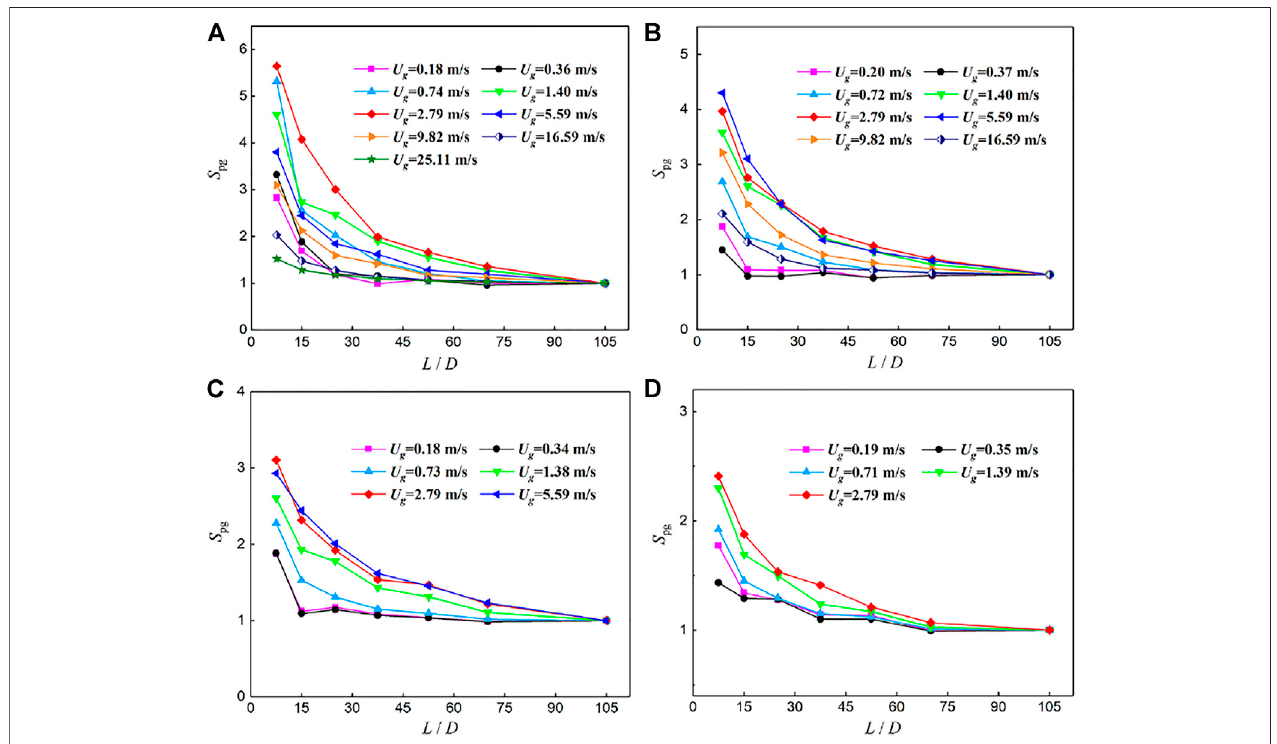
FIGURE5| Axialdevelopmentof S pg forthedownstreamstraighttube oftheU-bend( D =9 mmand R =37.5 mm)forthedownward fl ow (A) U l =0.20 m/s; (B) U l = 0.41 m/s; (C) U l = 0.89 m/s; and (D) U l = 1.98 m/s.